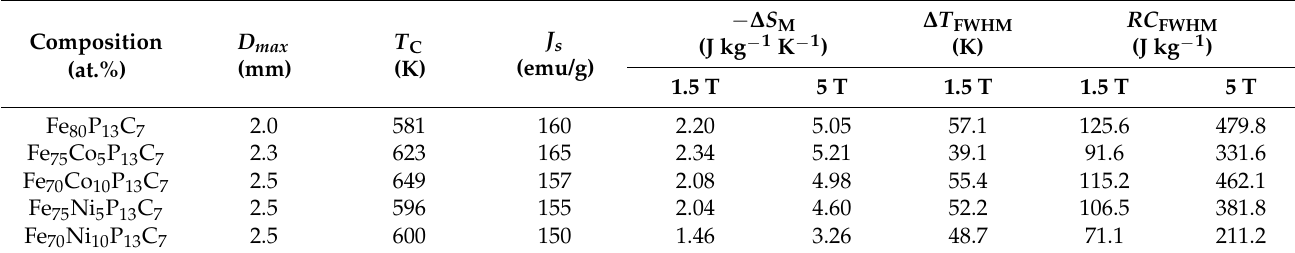
Figure 3. The hysteresis loops of the as-cast Fe 80-x M x P 13 C 7 (M = Co, Ni; x = 0, 5 and 10 at.%) glassy alloy rods at room temperature and the inset is the enlarged part of the magnetization curve. Table 1. The maximum diameter for fully glass formation ( D max ), magnetic transition temperature ( T C ), the saturation magnetization ( J s ) and magnetocaloric properties at the magnetic applied field of 1.5 T and 5 T for the present Fe 80-x M x P 13 C 7 (M = Co, Ni; x = 0, 5 and 10 at.%)